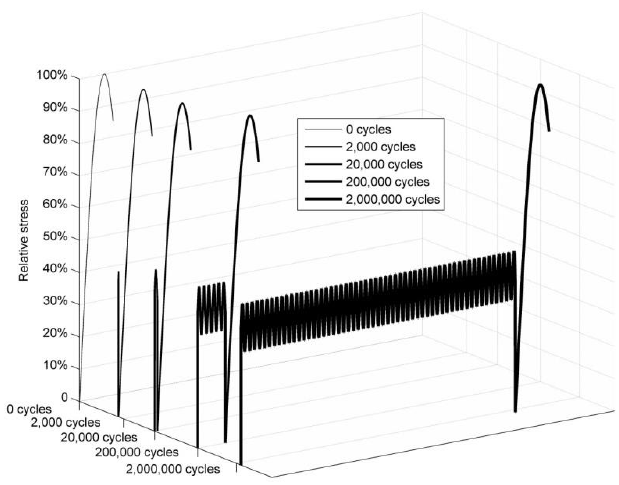
Figure 1. Testing Figure 1. Testing procedure.